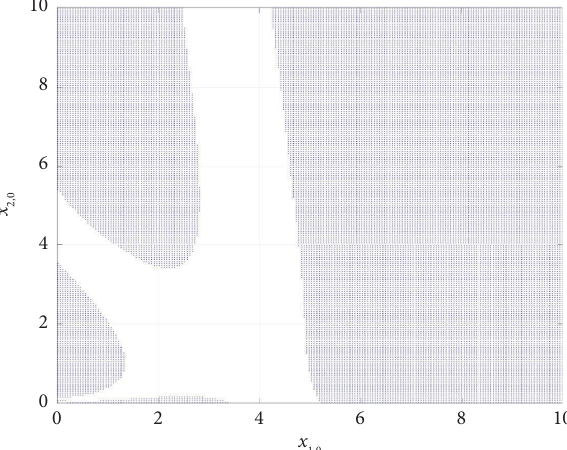
Figure 4: Lyapunov exponent L calculated from map (1). Parameter values ( μ ,x ∗ ) and (b) ( x ( x ∗ 1 2